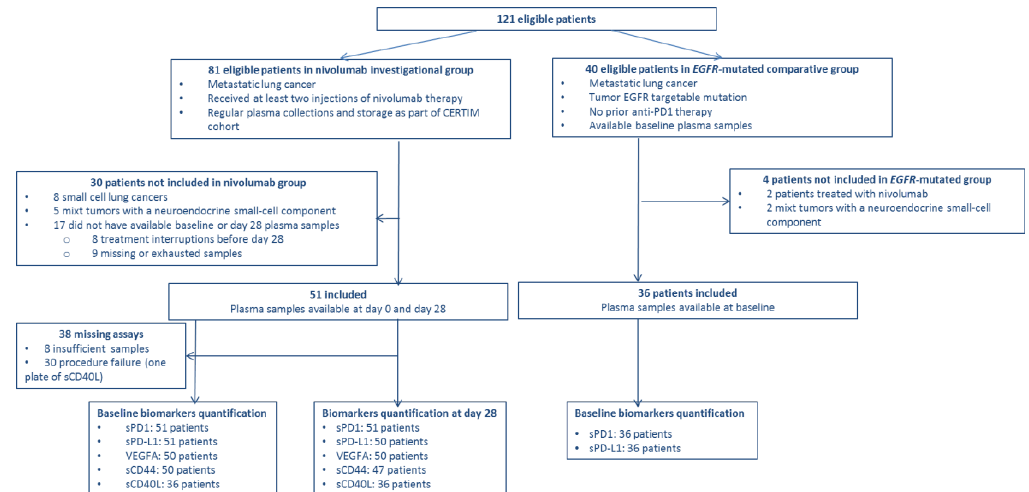
Figure 1. Flow chart.